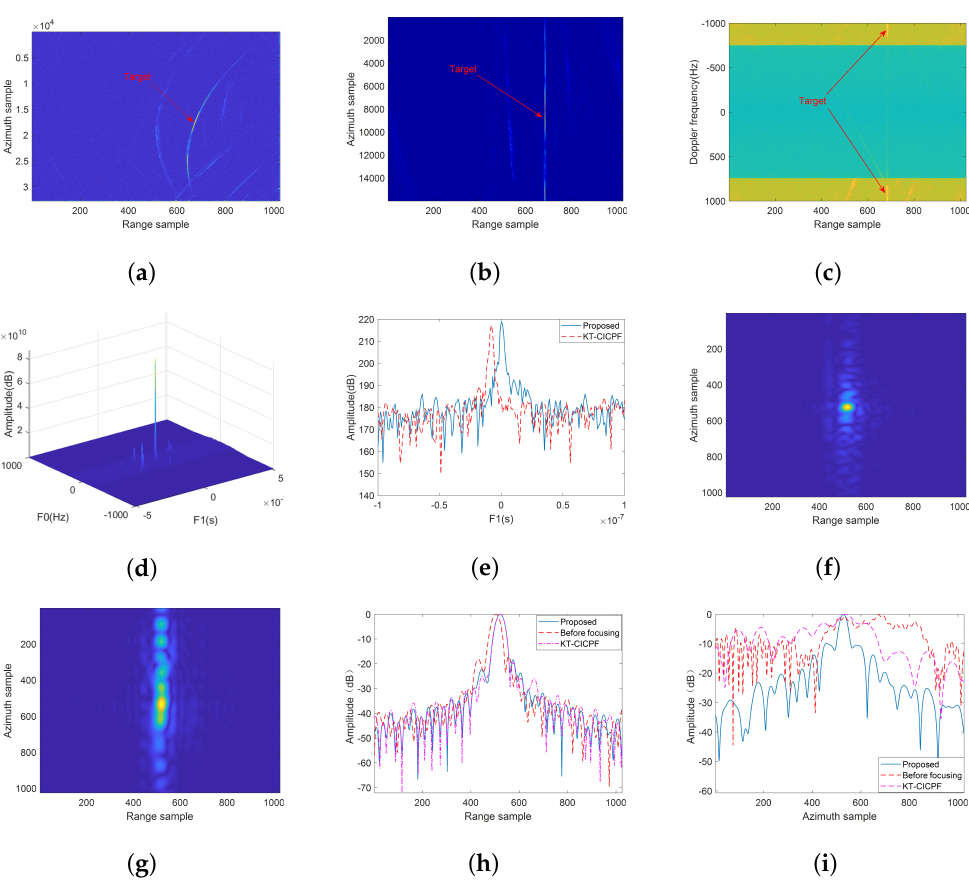
Figure 10. Image of the stationary scene without processing of GMT. ( a ) Image of the stationary scene (the yellow pentagram indicates the target’s relocation position). ( b – d ) Magnified images of moving targets (defocused).